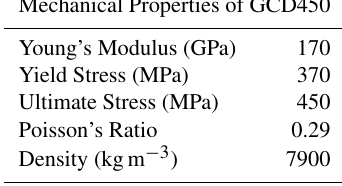
Table 2. Material properties of knuckle used in finite element sim-